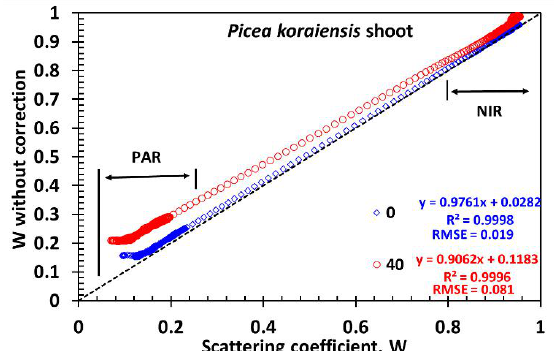
Figure 5. Correlation between scattering coefficients of the Picea koraiensis shoot derived with (horizontal axis) and without (vertical axis) correction for the needle surface effects. In this example, relative differences are 17%–140% in blue (450–500 nm), 3%–74% red (600–650 nm), 3%–59% green (520–580 nm ) and below 4% in the near infrared (800–950 nm) spectral intervals.